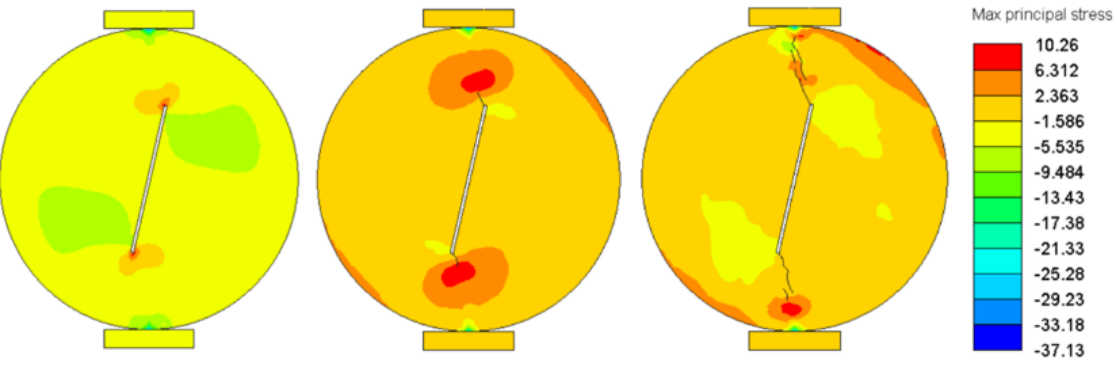
Figure 11. Evolution of maximum principal stress for Brazilian disc with crack of 15° angle.